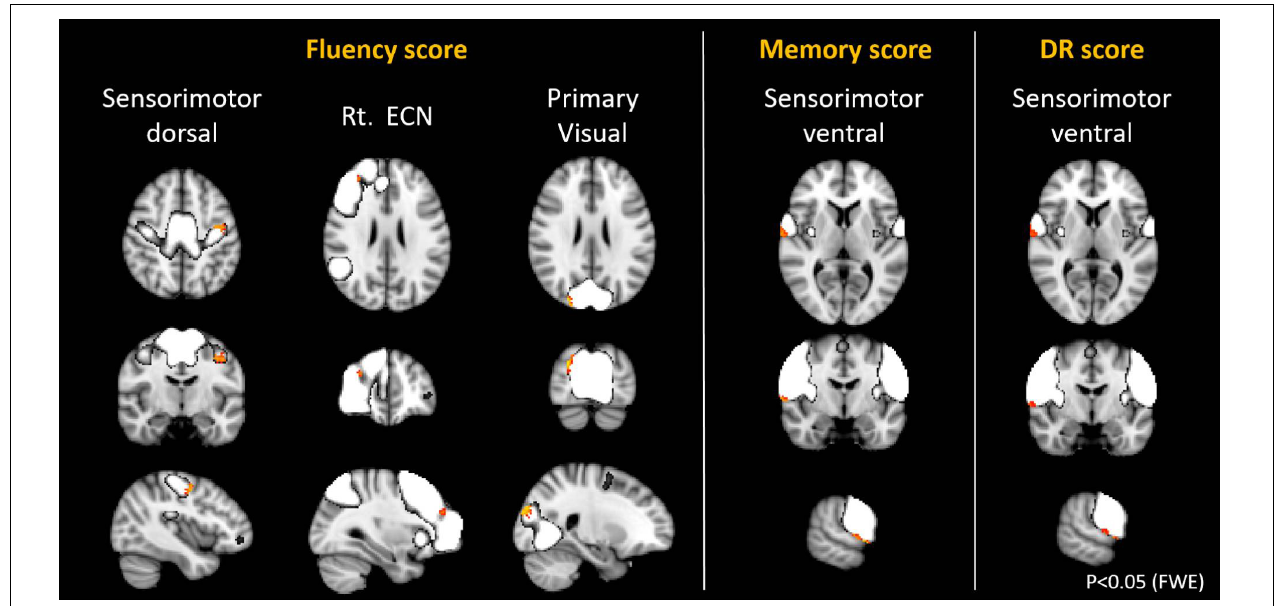
FIGURE 6 | Resting state networks, shown in white, with within-network functional connectivity values that positively correlated with the score of fluency, memory, and delayed recall (DR). The clusters shown in yellow-red represented the areas with connectivity values showing significant positive correlation with the different scores (FWE p <